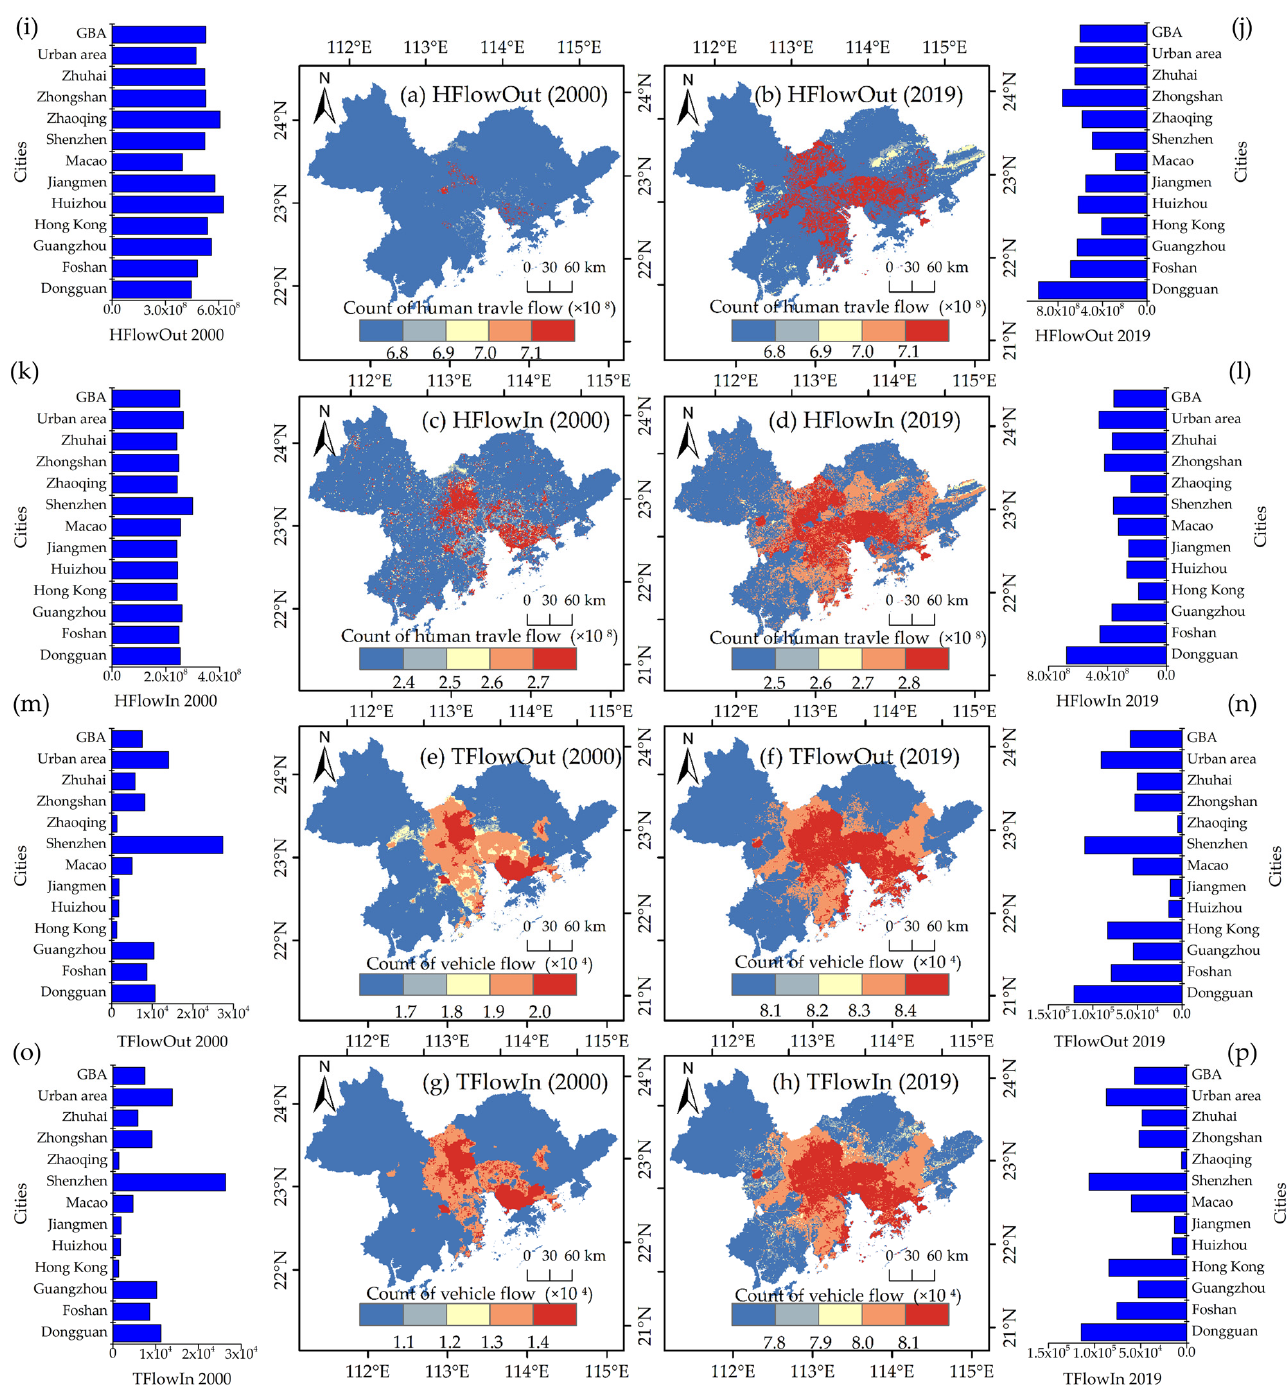
Figure 4. Spatial change trend for the indices of mobile human activity from 2000 to 2019. ( a , b ) depicted the indices of human travel outflow in 2000 and 2019, respectively. ( c , d ) depicted the indices of human travel inflow in 2000 and 2019, respectively. ( e , f ) depicted the indices of vehicle outflow in 2000 and 2019, respectively. ( g , h ) depicted the indices of vehicle inflow in 2000 and 2019, respectively. The bar graph from ( i – p ) on the left and right were the statistical result of the indices of mobile human activity.